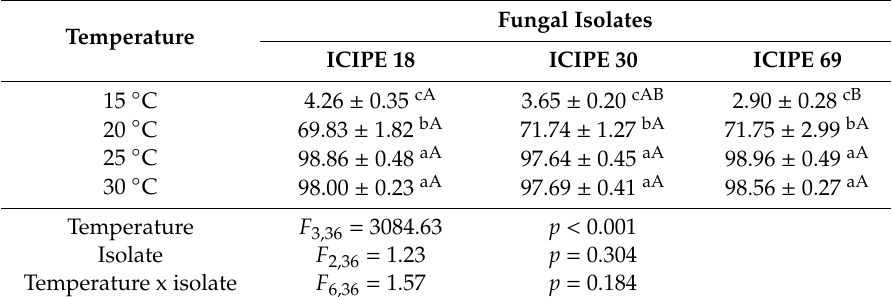
Table 1. Percentage germination of Metarhizium anisopliae isolates at di ff erent temperatures.